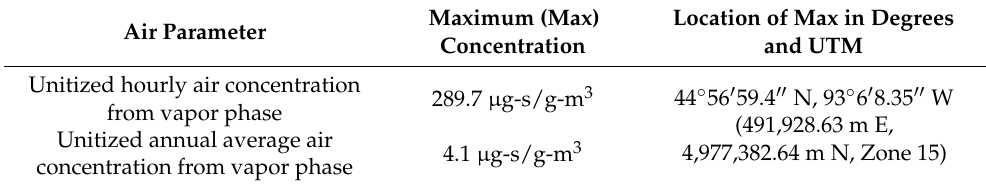
Table 6. Benzene Maximum Concentration Values and their Respective